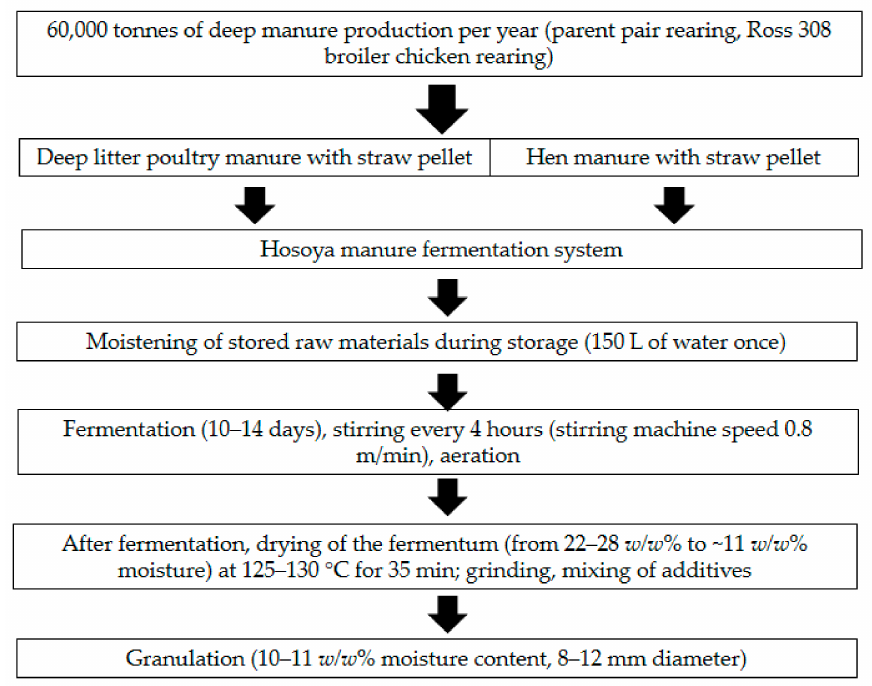
Figure 1. The schematic of the poultry manure utilization